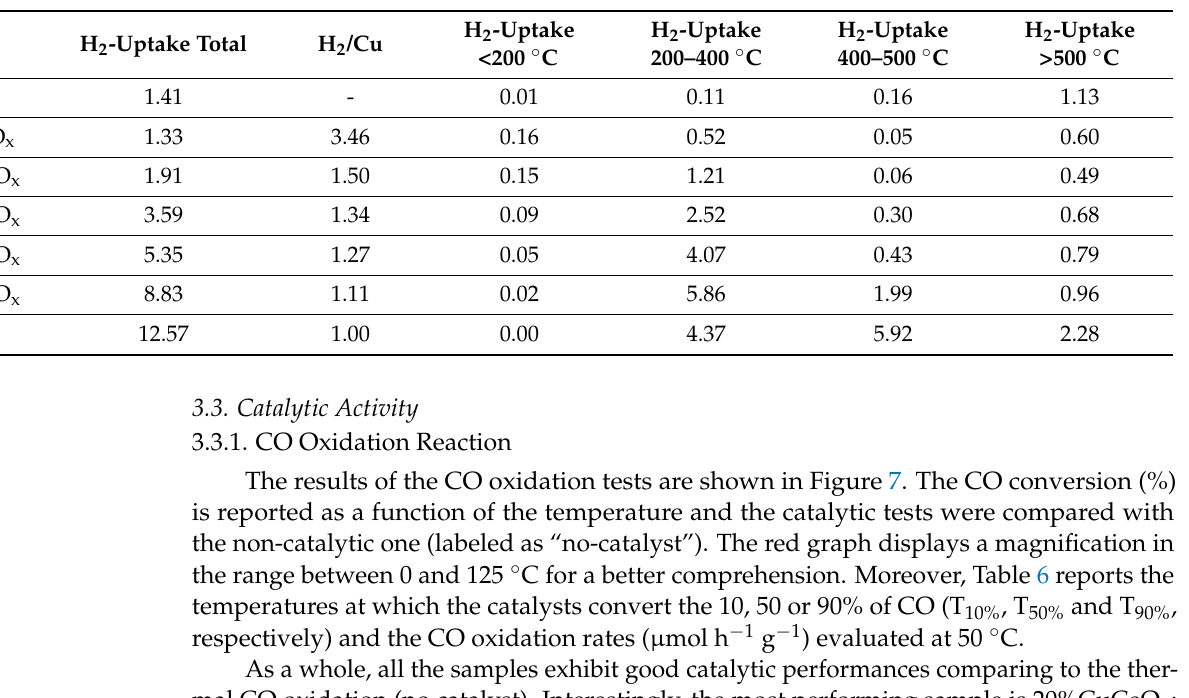
Table 5. Hydrogen consumption (mmol g − 1 ) evaluated by H 2